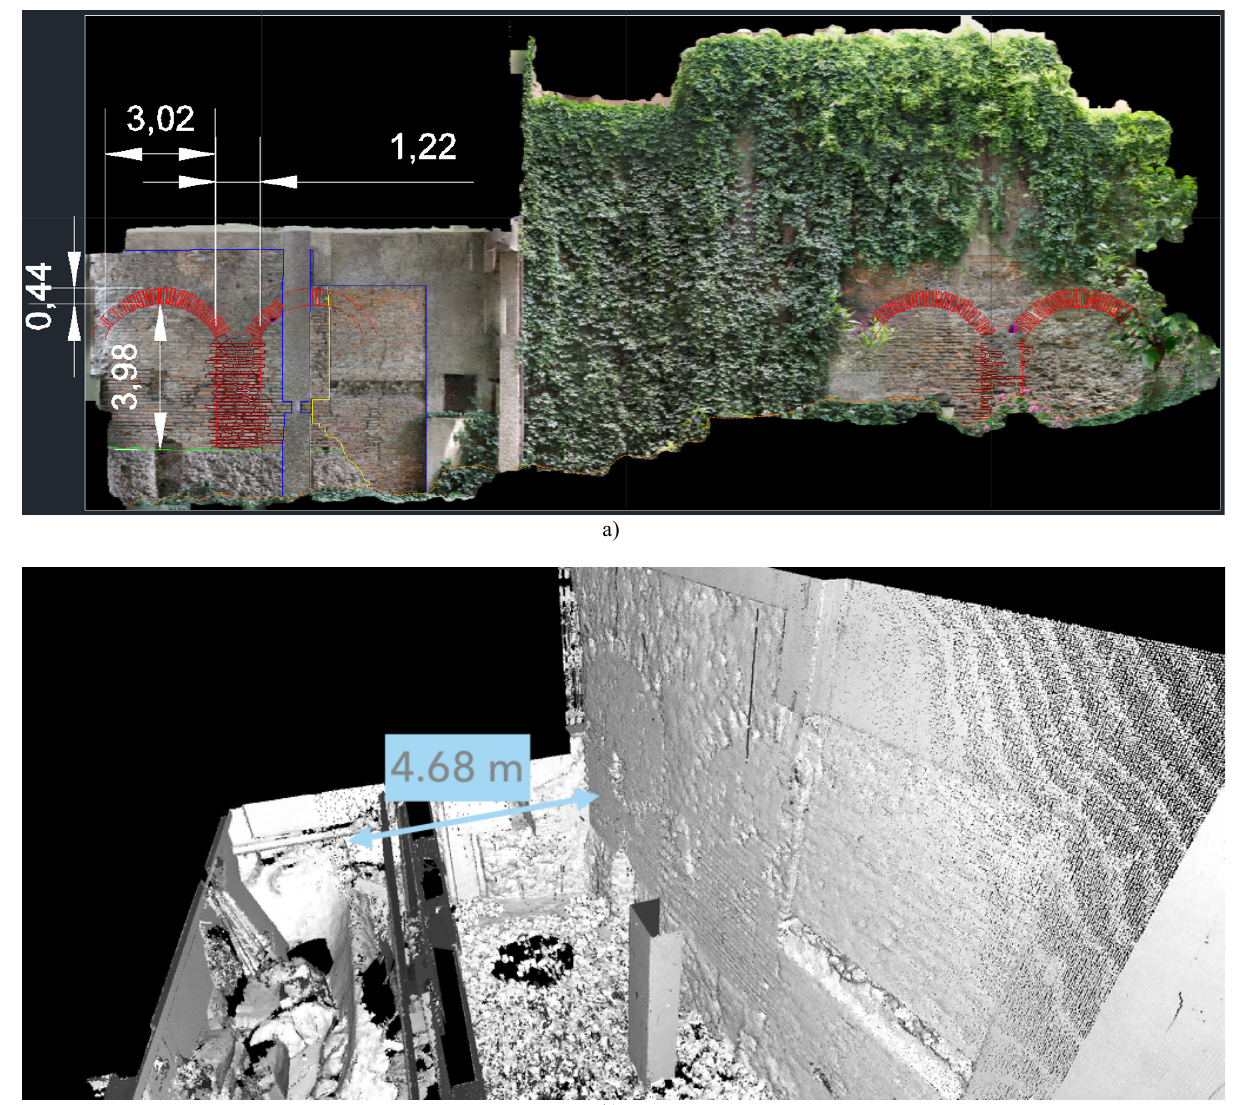
Figure 3. Documentation of main portion of the circus outer wall still standing: a) orthoimage, providing the measurement of the arches supporting the audience seats; b) laser scan including a small remain of the small inner wall found in a private